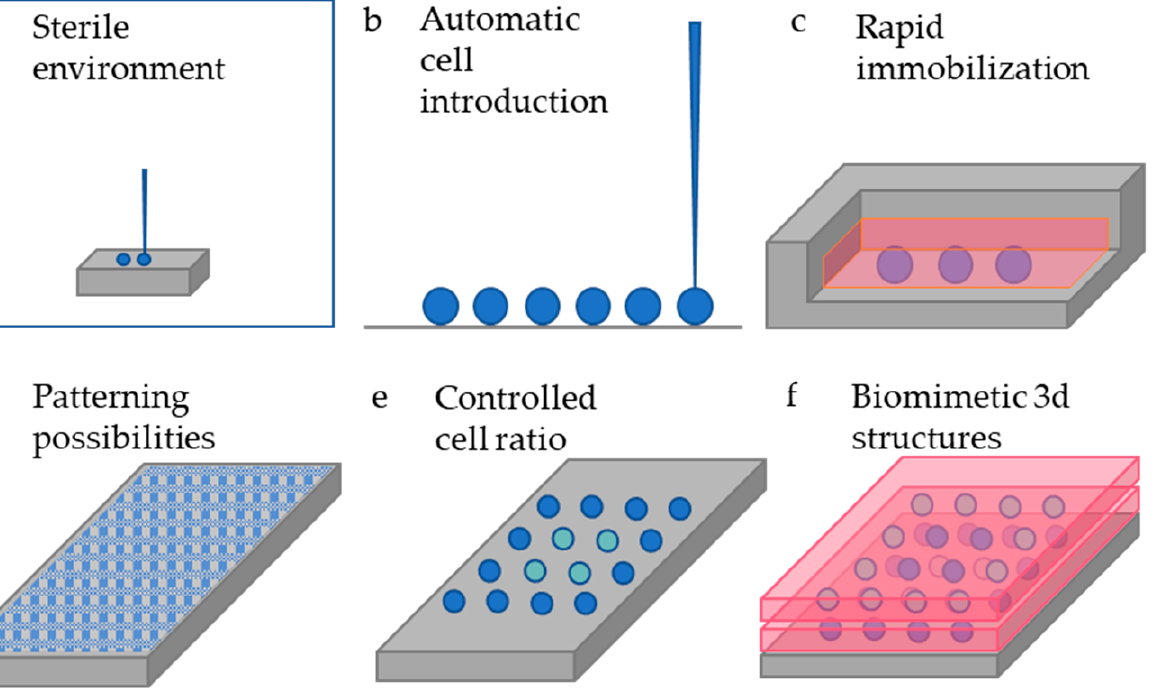
Figure 1. ( a ) Bioprinters and microfluidic devices can be installed in a sterile environment, ( b )